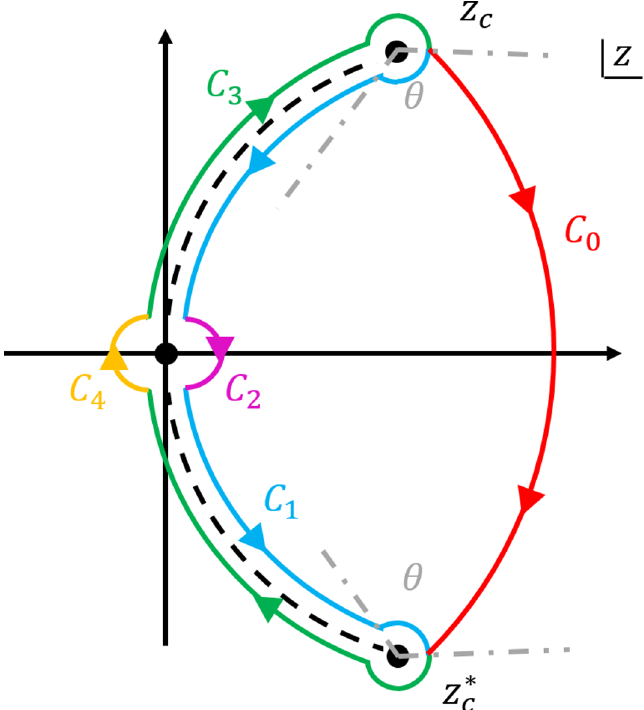
Figure 27 . The original integration contour C 0 and its deformations. The black dashed line is the branch cut. The angle θ at which C 1 and C 3 meet is chosen carefully according to a principal value